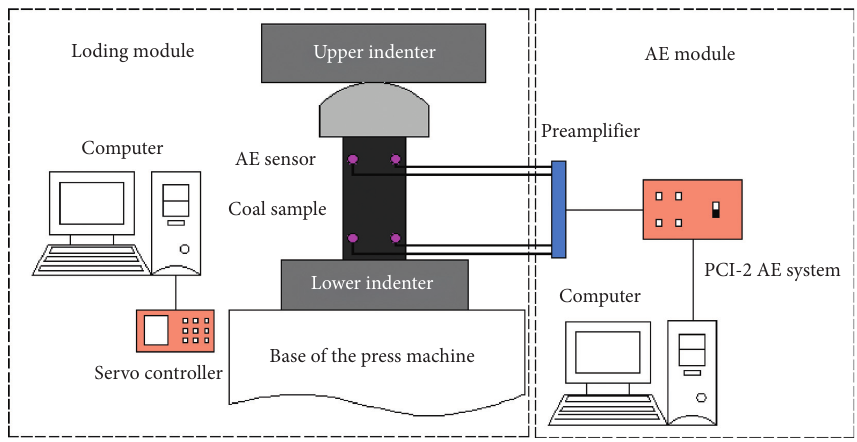
Figure 1: Test system for static mechanical properties of coal